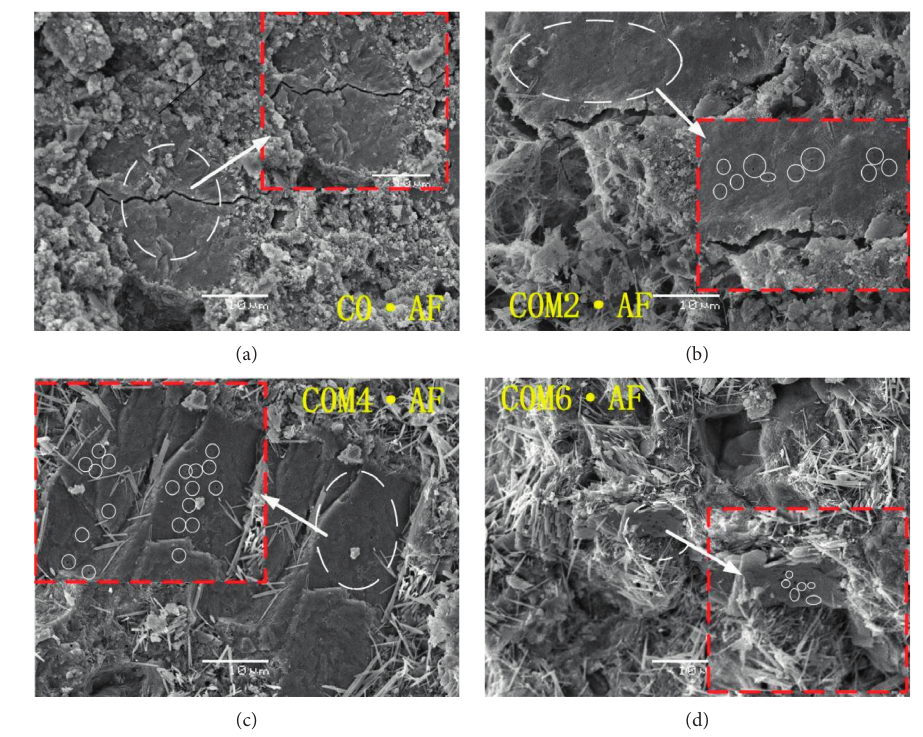
Figure 6: Characteristics of the microstructure of CGCC aggregate after freeze-thaw cycles (2000x).